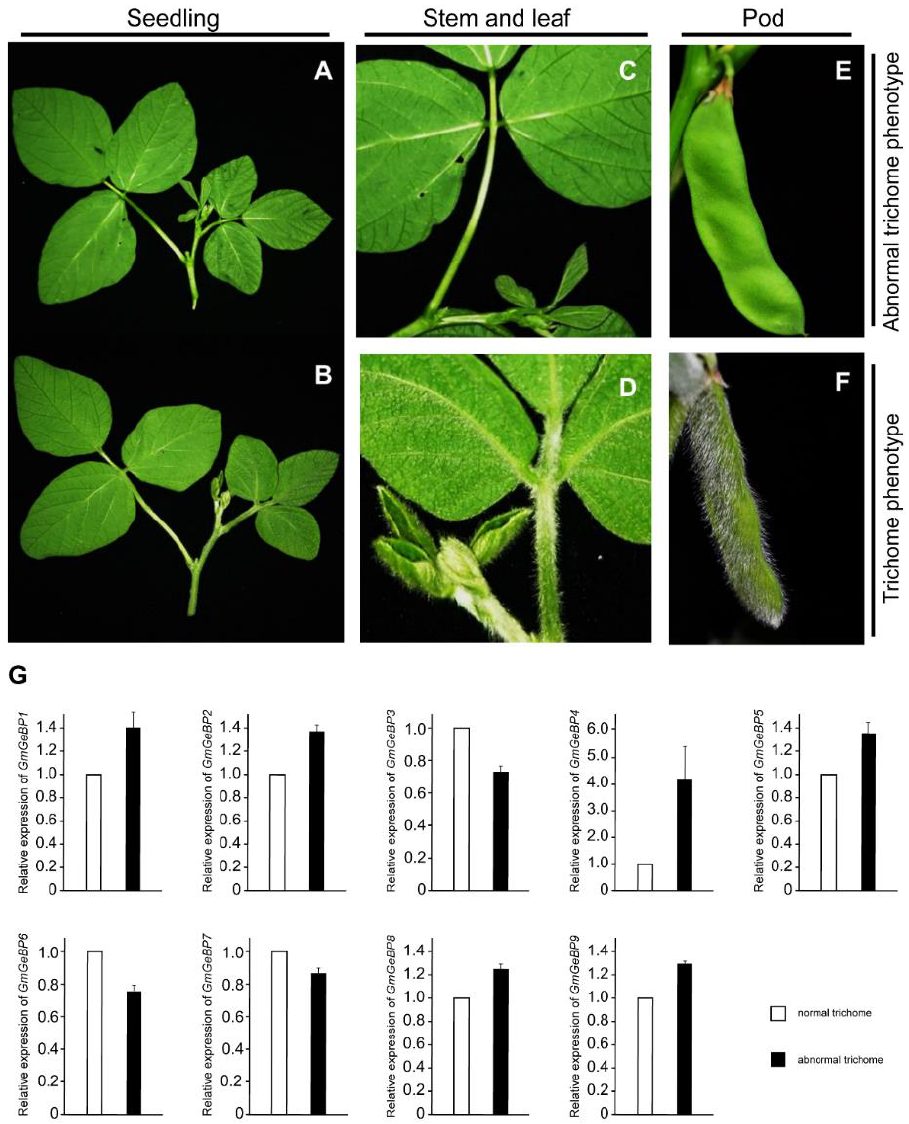
Figure 5. Expression levels of GmGeBP genes in abnormal and normal trichome soybean. ( A , C ) Phenotype of abnormal trichome soybean. ( B , D ) Phenotype of trichome soybean. ( E ) Phenotype of abnormal trichome soybean pod. ( F ) Phenotype of trichome soybean pod. ( G ) Quantitative RT-PCR was used to investigate the expression levels of GmGeBP genes, and the results are represented by means ± standard deviations. The relative expression levels of GmGeBP genes in abnormal trichome soybean are compared with those in trichome soybean.